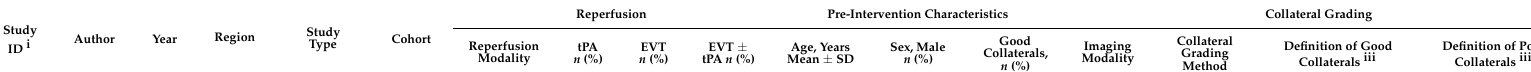
Table 1. Clinical characteristics of studies included in the